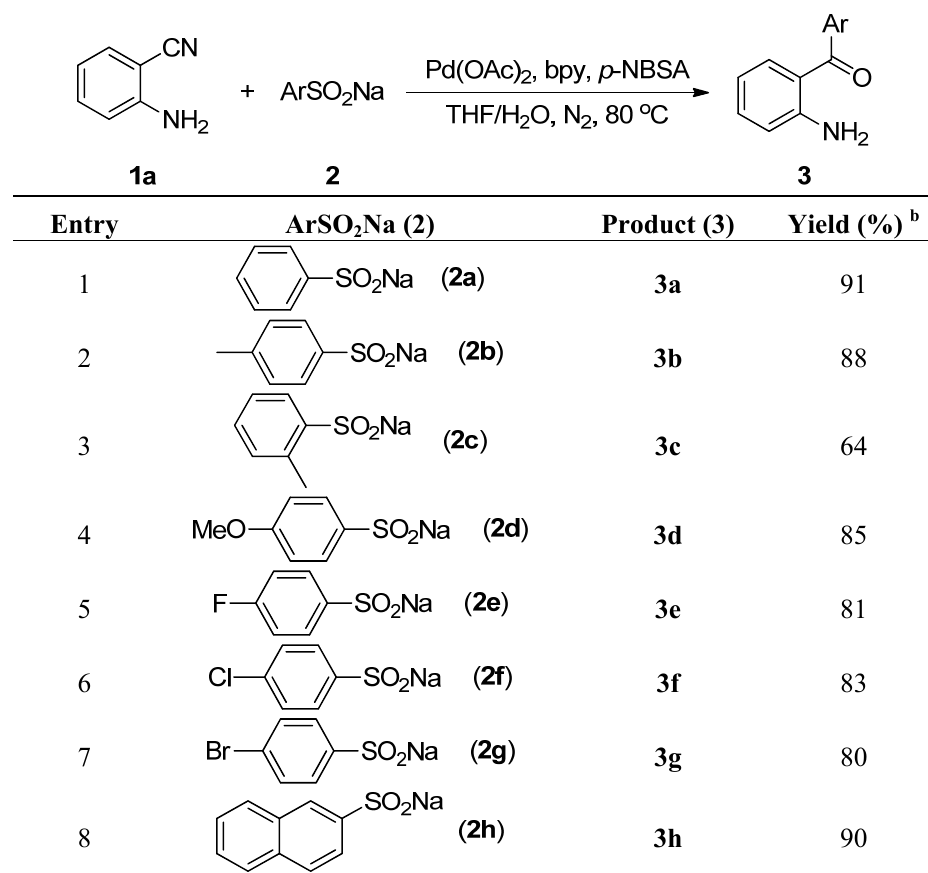
Table 2. Substrate scope of sodium arylsulfinates a